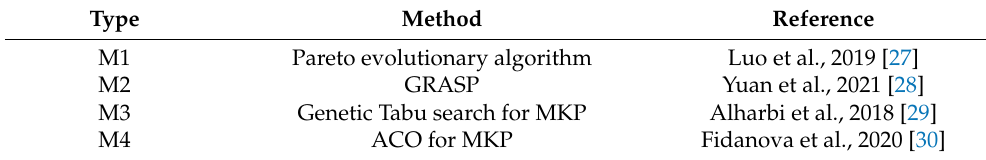
Table 4. List of competitors’ techniques to associate MKP dataset for